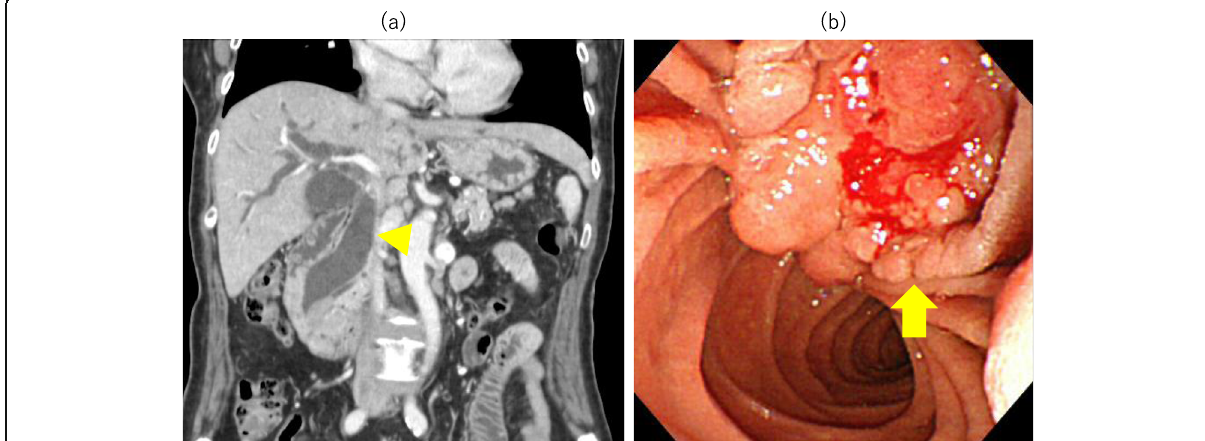
stenosis (Fig. 2). A biliary stent was endoscopically.